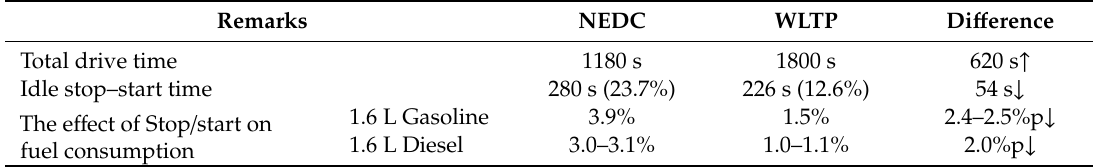
Table 8. Comparison of fuel consumption for idle stop–start by test